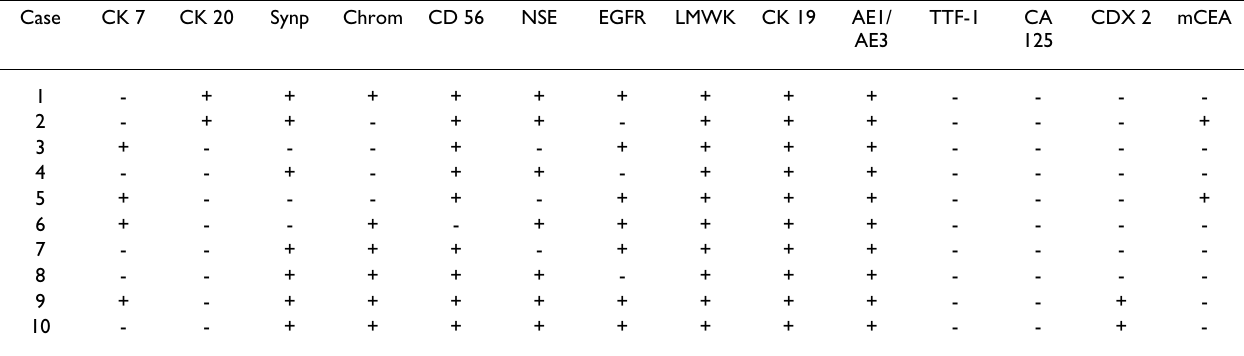
Table 3: Summary of immunohistochemical staining